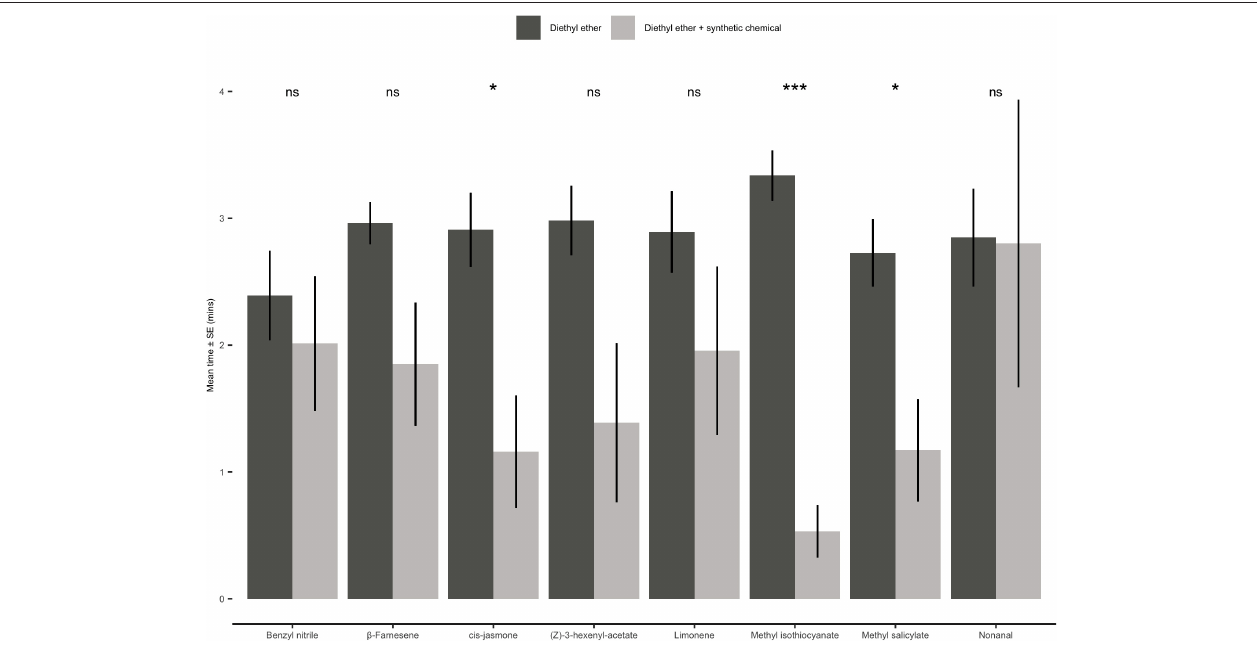
FIGURE 7 | Behavioural responses of Myzus persicae females to eight synthetic chemical compounds. Individual aphids were given 12min to make a choice between one arm containing a synthetic chemical compound vs. three solvent diethyl ether arms. The shown values are mean time spent in arm ± SE ( n = 10). Synthetic chemical compounds capped with “ns” do not show a significant difference while asterisks denote differing levels of statistical significance: * < 0.05 and *** < 0.001 (paired t- test).